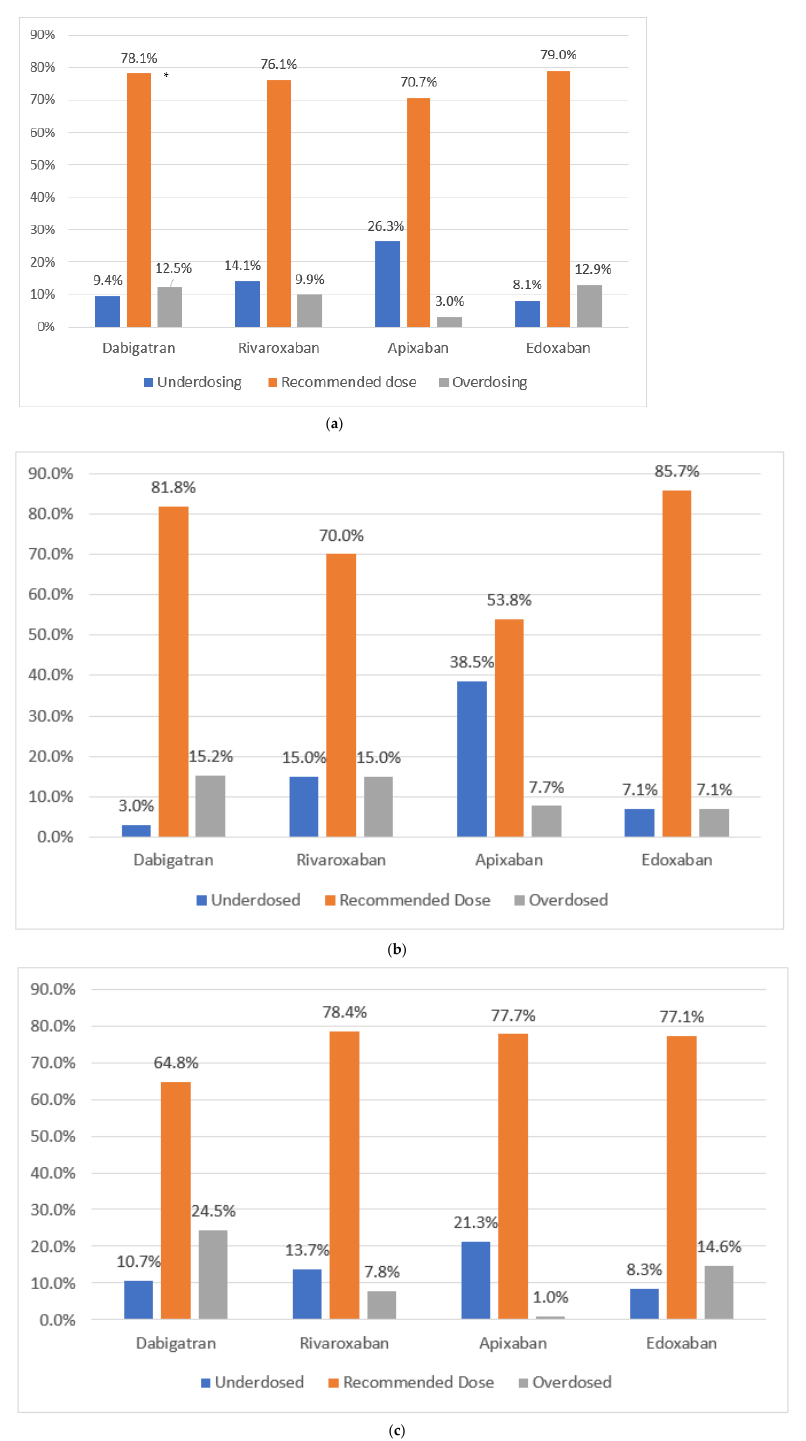
Figure 1. Appropriateness of NOAC dosing by NOAC type according to SmPC recommendations in the ( a ) overall population, in ( b ) patients with frailty, and in ( c ) patients without frailty. Appro ‐ priate dose according to the SmPC. Inappropriate dose includes under and overdosed patients, according to the SmPC recommendations. Frailty was defined as CFS > 4. *: For dabigatran, un- derdosed/overdosed should not really be considered as such, but as an appropriateness of doses recommended in the SmPC, because both doses were randomized in the RE-LY clinical